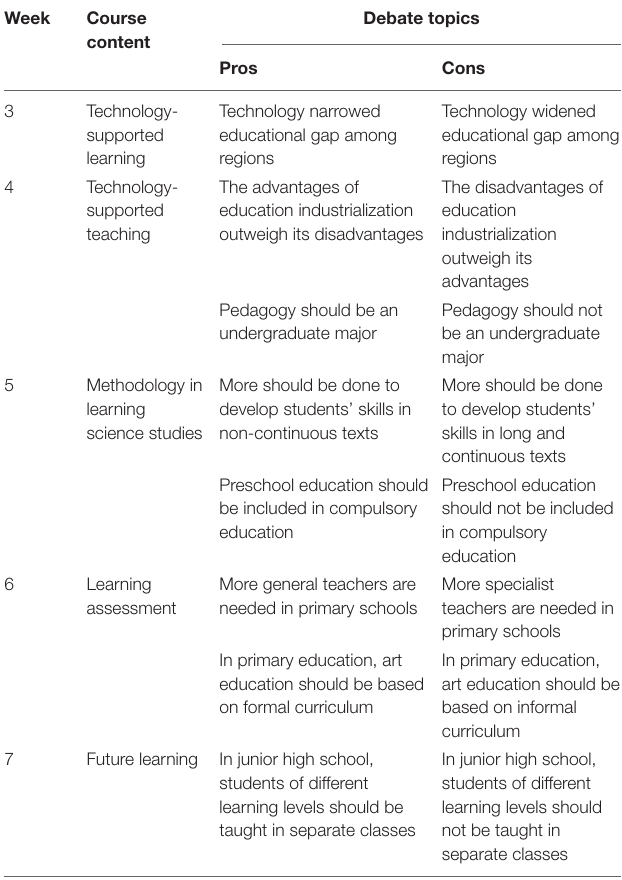
TABLE 1 | Debate topics in the five weeks (from the 3rd to the 7th